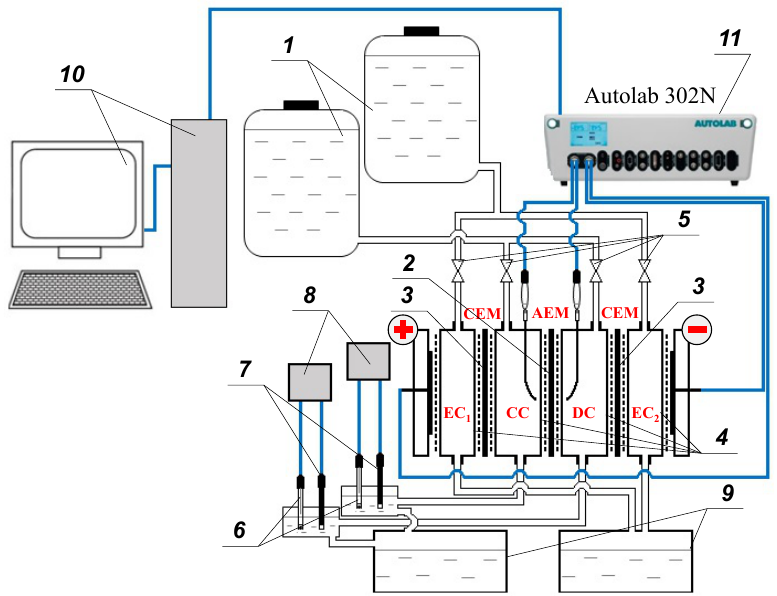
Figure 2. Schematic diagram of a setup for studying the electrochemical characteristics of anion- exchange